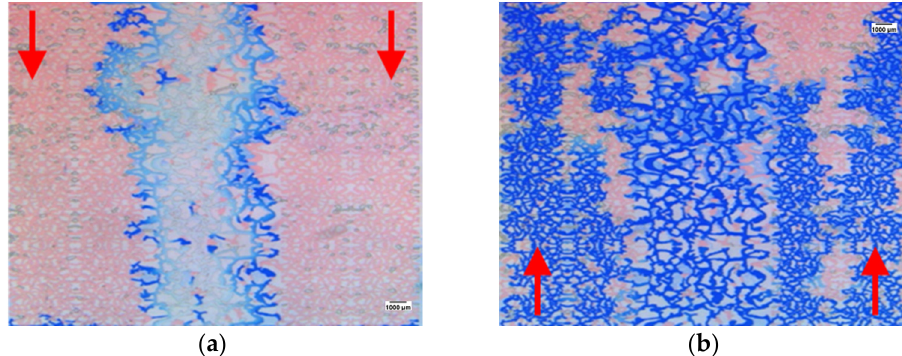
Figure 10. The subsequent water invasion process diagram after polymer microsphere injection and microsphere expansion in the heterogeneous model. ( a ) The emulsifier is injected along the simulated “horizontal wellbore”; ( b ) end of the second water flooding.